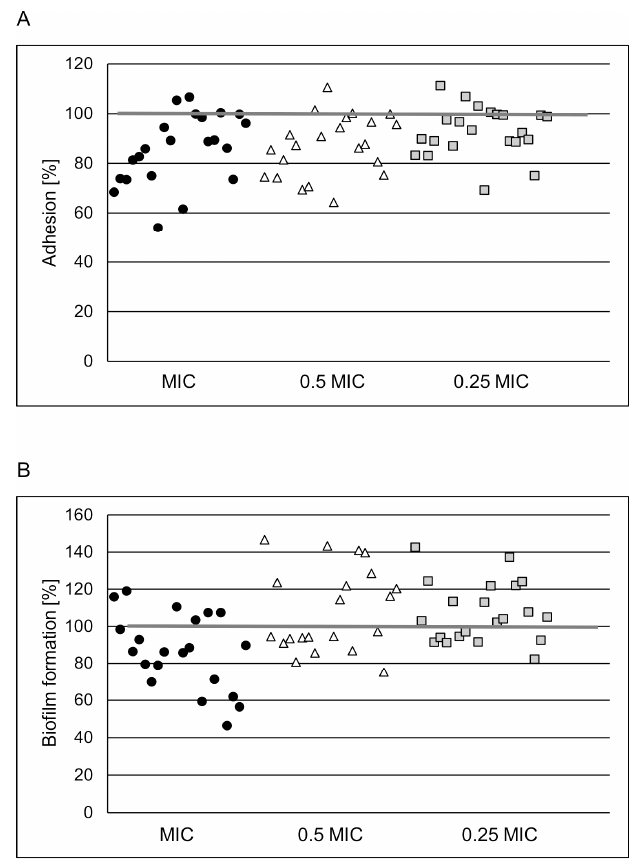
Figure 1. Adhesion ( A ) and biofilm formation ( B ) by S. aureus reference and clinical strains (n = 2 + 20) on abiotic surface in the presence of POE used at MIC (circles), 0.5 × MIC (triangles), 0.25 × MIC (squares), tested by a LIVE/DEAD BacLight Bacterial Viability Kit. The percentage of adhered cells or biofilm biomass compared with positive control (untreated bacteria) considered as 100% is presented.